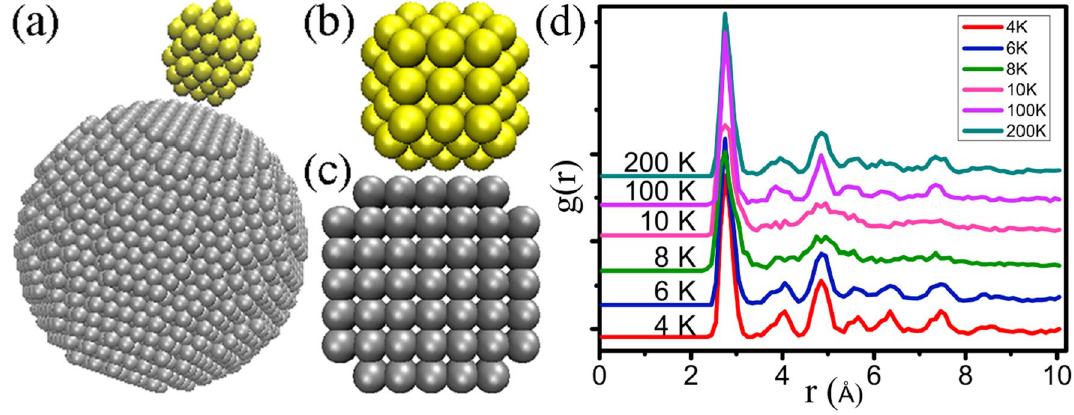
Figure 2. ( a ) The configurations of the simulated NP1 after a relaxation ( b ) (100) face of Au atoms ( c ) (100) face of Ni atoms ( d ) PDF of Au atoms in various temperatures.